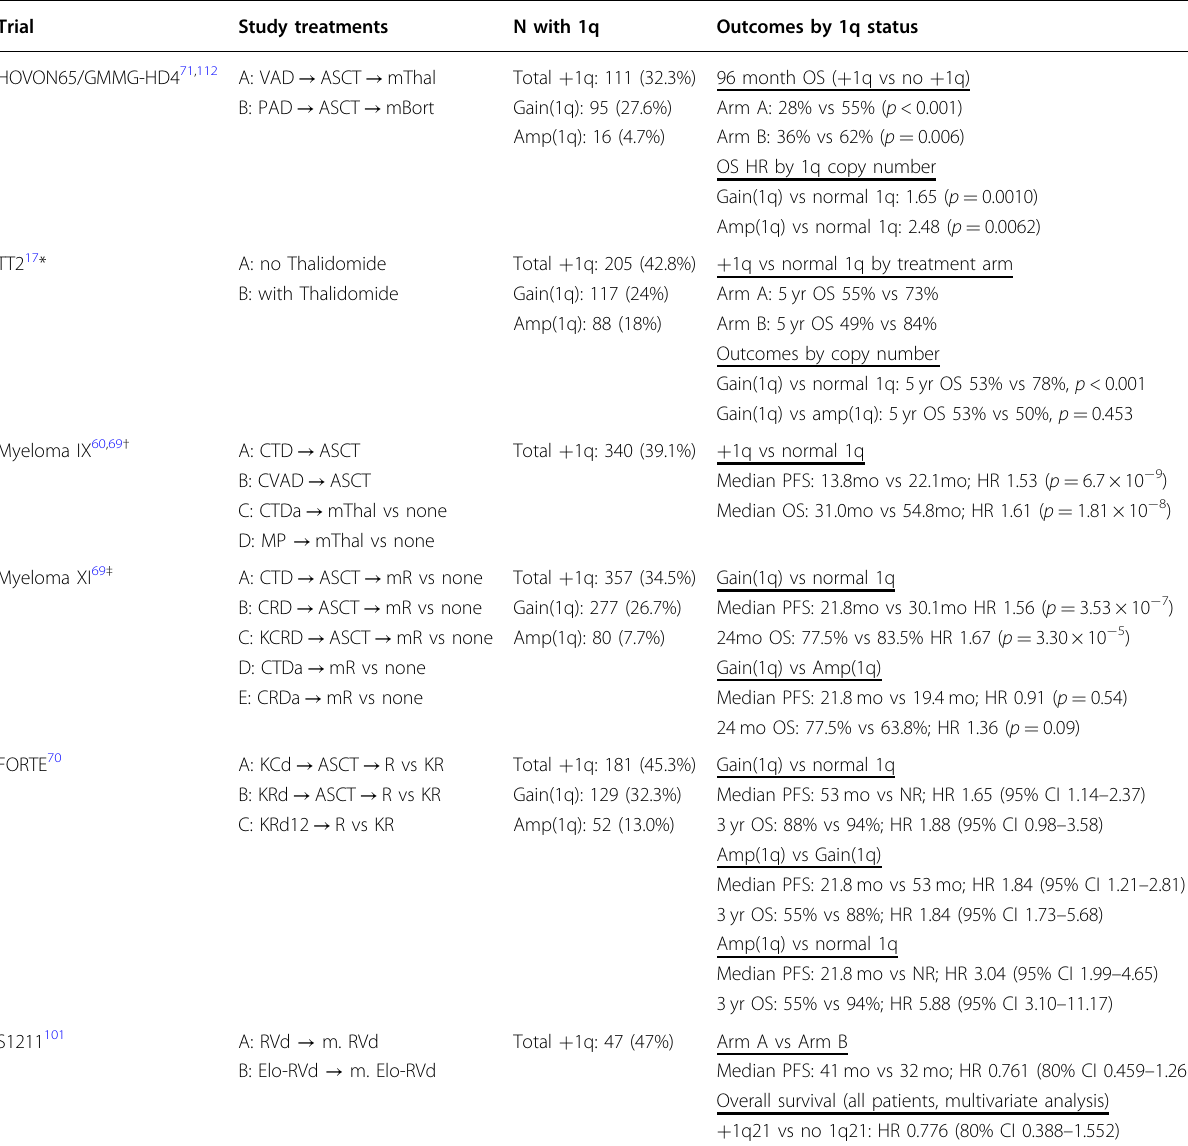
Table 2 Outcomes of patients with + 1q in randomized studies of newly diagnosed multiple myeloma. Trial Study treatments N with 1q Outcomes by 1q status HOVON65/GMMG-HD4 71,112 A: VAD → ASCT →